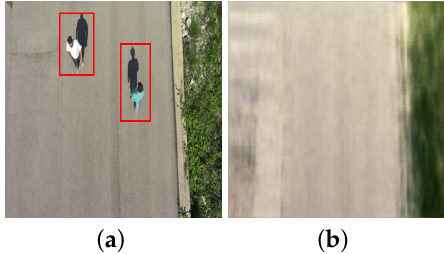
Figure 3. Example of image reconstruction of a frame depicting abnormal elements during the test phase. In ( a ) the abnormal frame; in ( b ) the reconstructed image of the repaired frame (i.e., removal of people in the middle of the street). Due to the anomaly correction, ( b ) has a low quality, resulting in a large Euclidean distance between ( a , b ) latent representations that indicates the detection of an